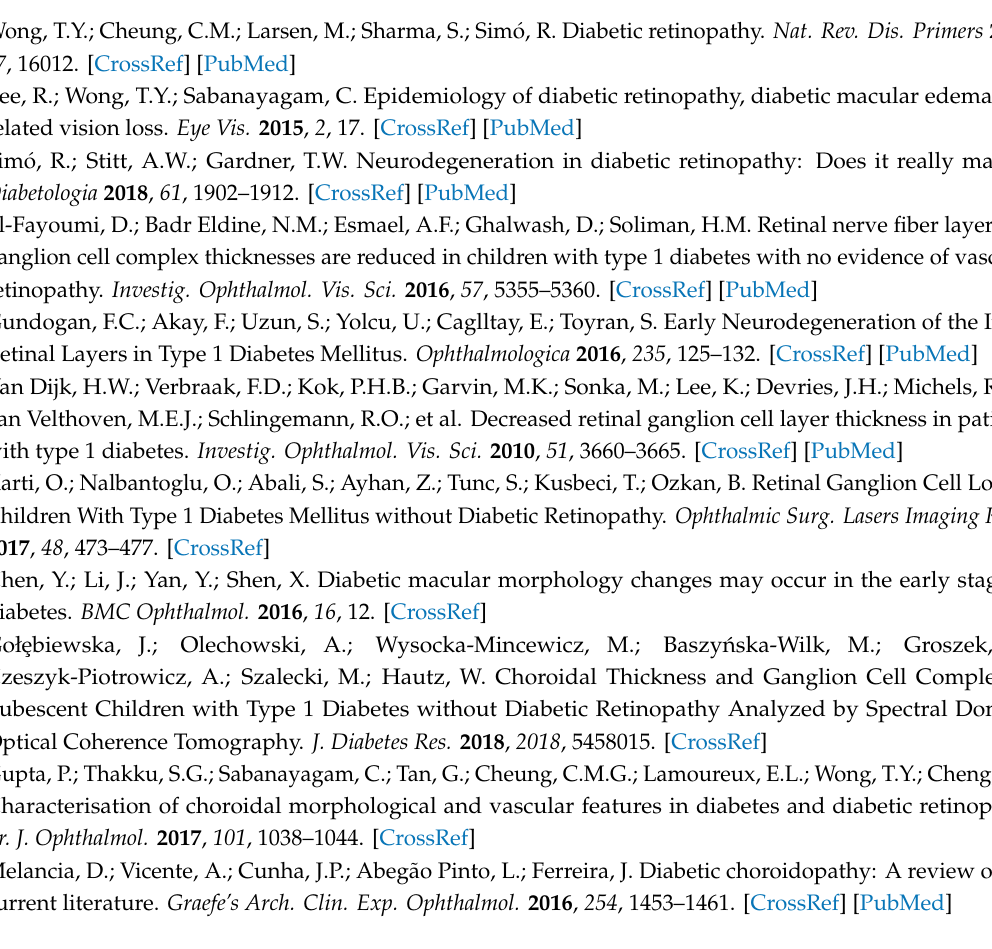
S2: Ophthalmological variables in the study population by group; Table S3: Univariate and multivariate analysis of the association between ophthalmological variables and type 1 diabetes with respect to the control group; and Figure S1: Retinal nerve fibre layer (RNFL) measurements by spectral-domain optical coherence tomography: (a) control subjects and (b) T1D subjects with mild DR. TEMP, temporal sector; SUP, superior sector; NAS, nasal sector; INF, inferior